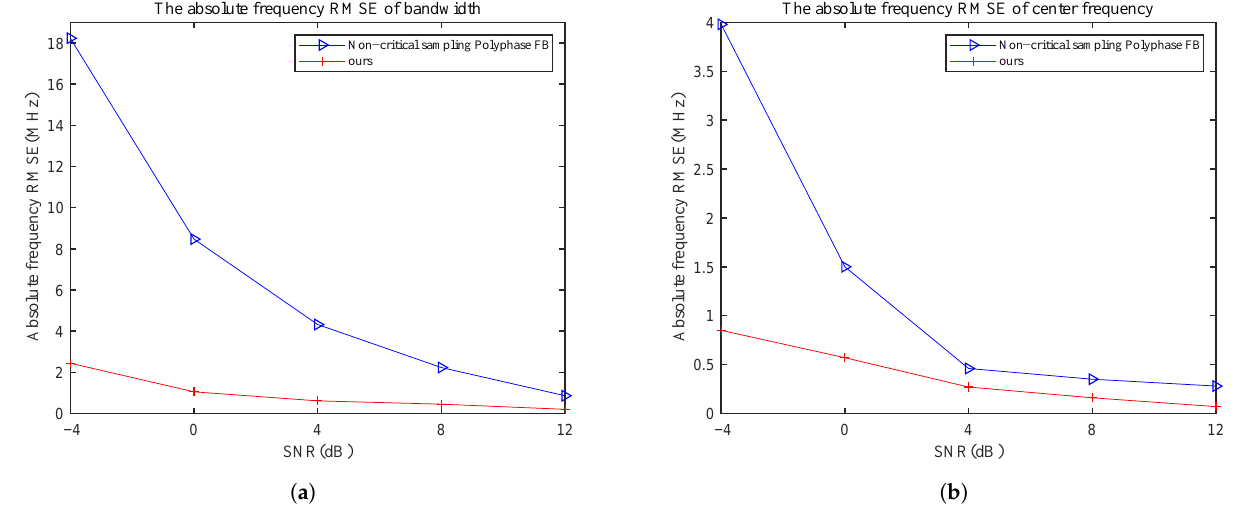
Figure 11. The absolute frequency root-mean-square error (RMSE) of bandwidth and center frequency with different SNR: ( a ) the absolute frequency RMSE of bandwidth; ( b ) the absolute frequency RMSE of center frequency. (The blue line indicates the results of the Refs. [17,32]; The red line indicates the results of the algorithm proposed in this paper).